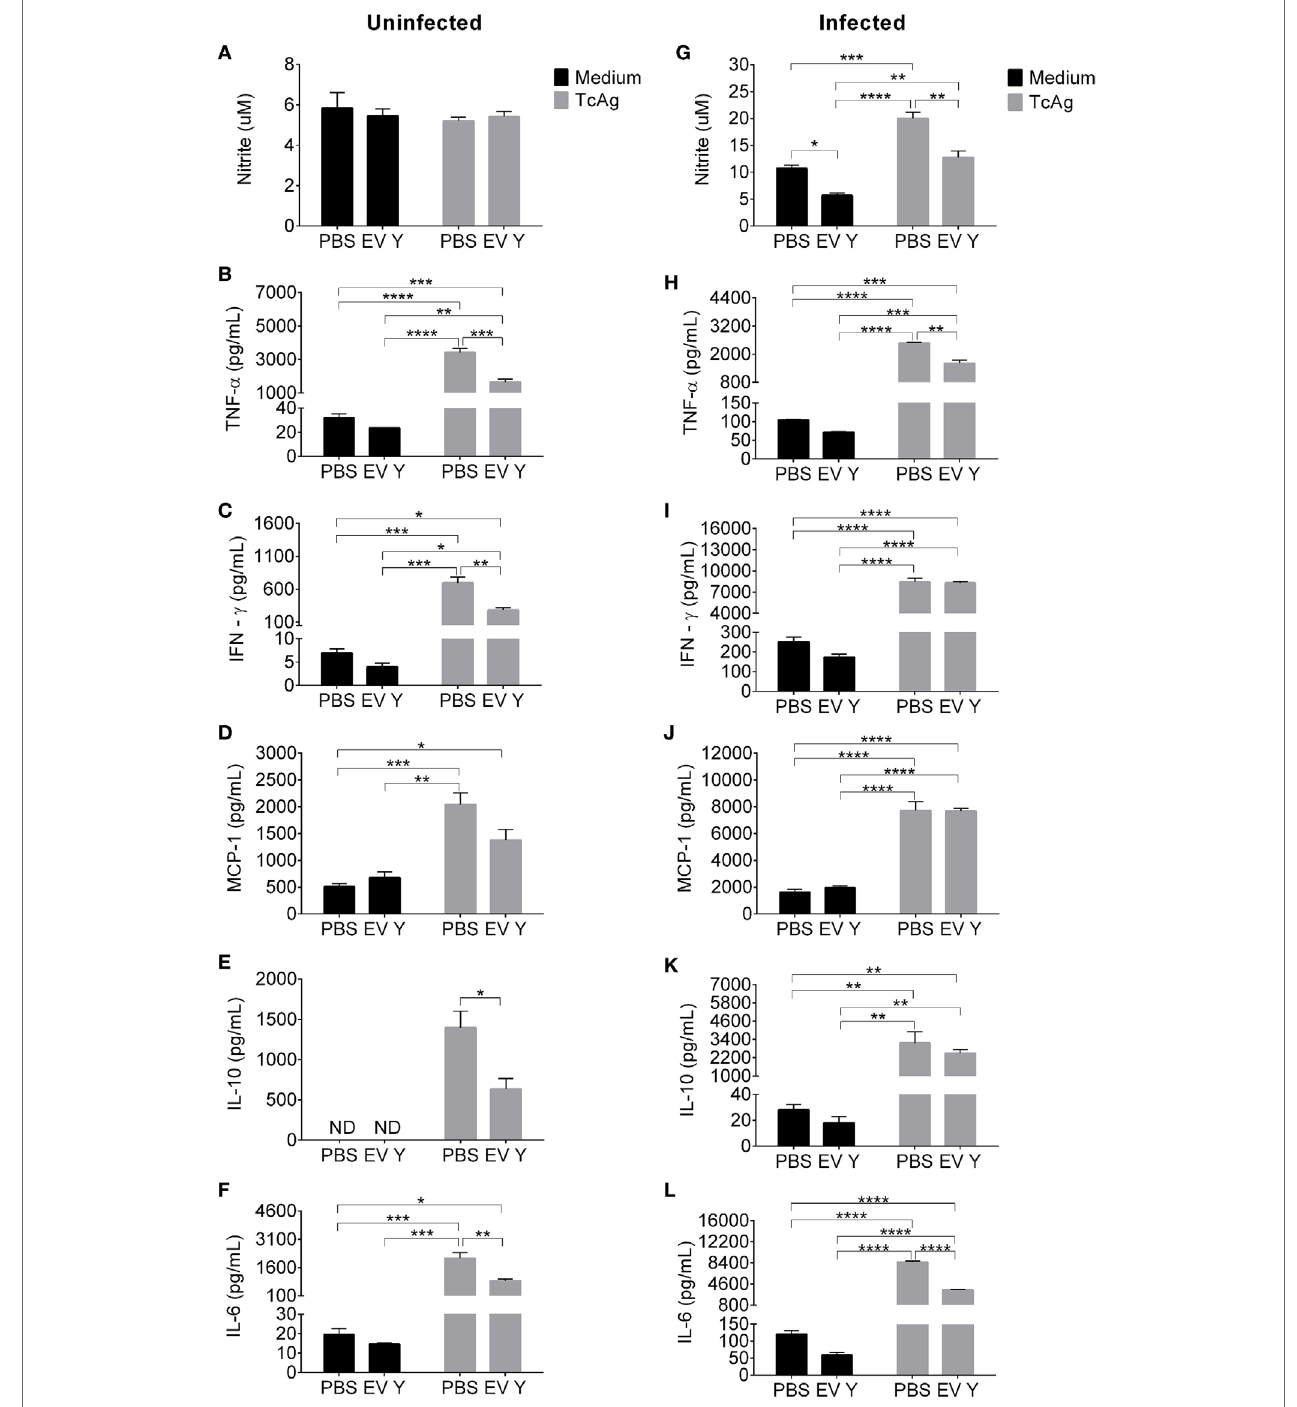
FigUre 3 | Inoculation of Trypanosoma cruzi extracellular vesicles (EVs) prior to infection decreases production of nitric oxide and cytokines by spleen cells from infected mice. C57BL/6 mice were inoculated with EVs derived from T. cruzi Y (EV Y) (i.p.). One week later, the mice were infected with T. cruzi (Y strain) by the same route. Infected, uninfected, and PBS-inoculated mice were used as controls. Spleens were harvested 12 days after T. cruzi infection (19 days after EV Y or PBS inoculation). The cells were cultured with medium or T. cruzi antigen (TcAg) for 48 h. (a,g) Nitrite in the supernatants of cultured spleen cells from uninfected mice (left column) and cultured spleen cells from infected mice (right column) were quantified by the Griess assay. Cytokines (B,h) TNF- α , (c,i) IFN- γ , (D,J) MCP-1, (e,K) IL-10, and (F,l) IL-6 in the supernatants of cultured spleen cells from uninfected and infected mice, respectively, were quantified by the Cytometric Bead Array. The results are expressed as the mean ± standard error from four mice per group in an experiment representative of two similar experiments. * P < 0.05; ** P < 0.01; *** P < 0.001; **** P < 0.0001 significantly different (two-way ANOVA with Tukey’s post-test)—GraphPad